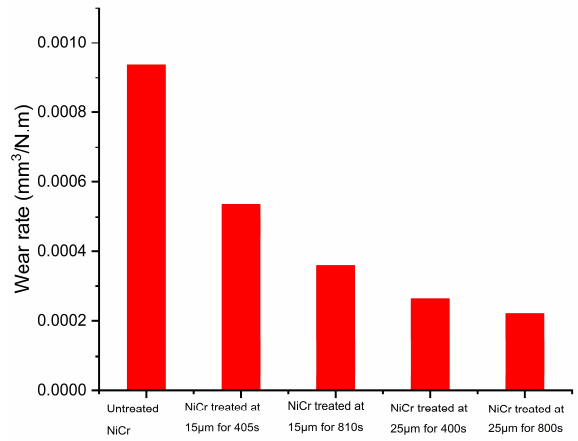
Figure 12. Wear rate of the coatings in different SMAT conditions.